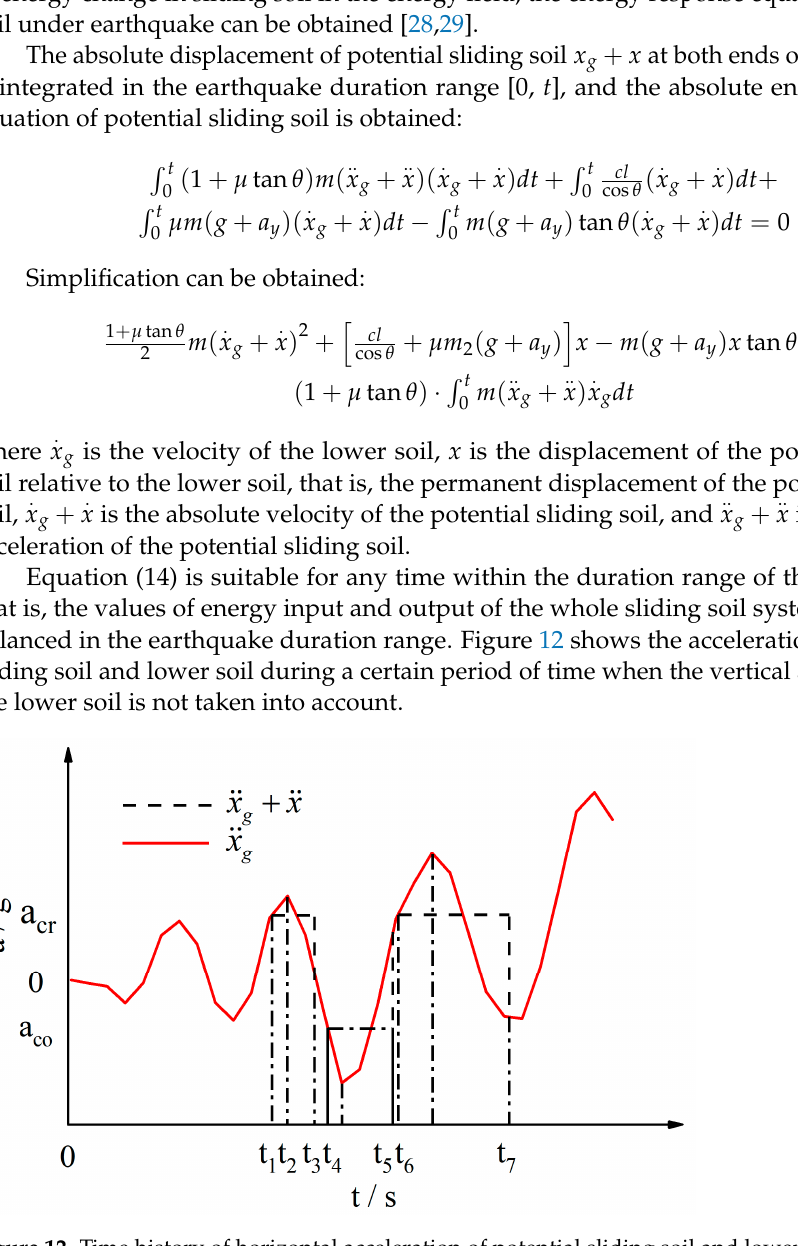
Figure 12. Time history of horizontal acceleration of potential sliding soil and lower